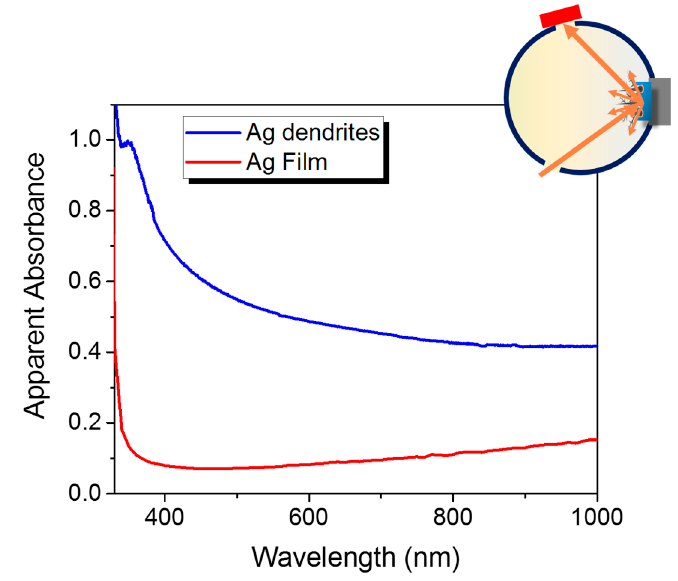
Figure 4. Ag plasmon resonance. Apparent absorbance spectra of the Ag reference film [55,56] (red spectrum) and Ag fractal dendrites (blue spectrum) obtained from the reflectance spectra carried out with an integrating sphere.